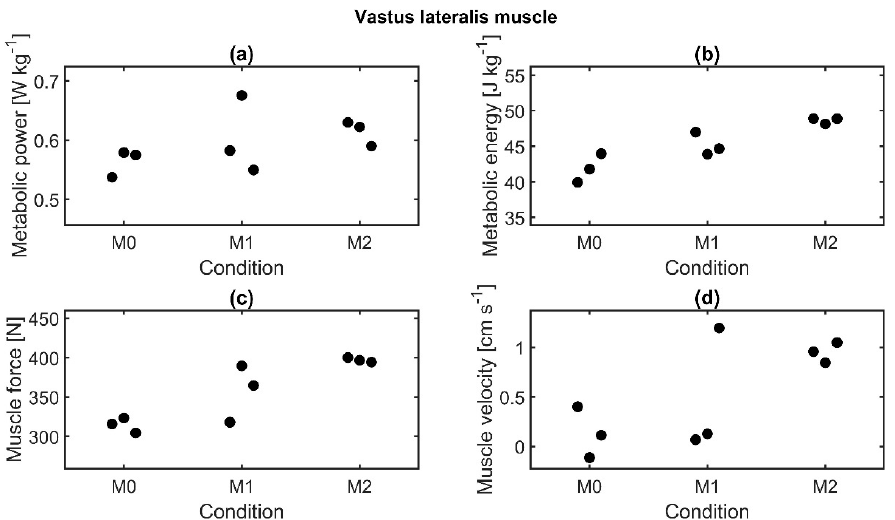
Figure 10. Muscle parameters of the vastus lateralis muscle of subject 8 for three repetitions per con- dition. Median values are displayed. ( a ) Metabolic power normalized to body weight, ( b ) metabolic energy normalized to body weight, ( c ) muscle force, and ( d ) muscle